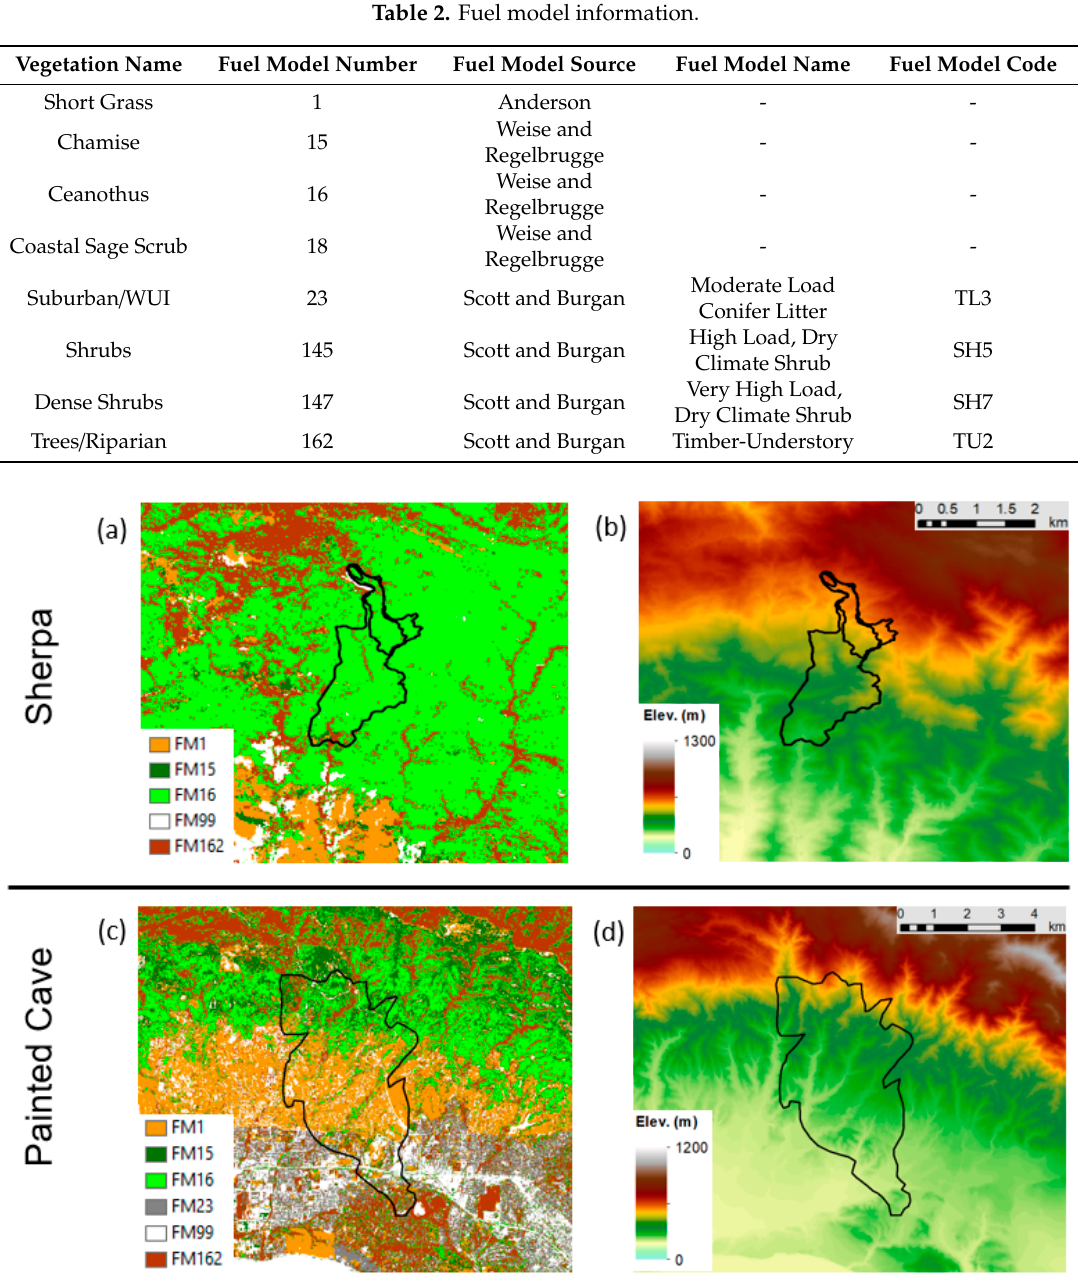
Figure 2. Fuel maps ( a , c ) and elevation ( b , d ) rasters for the Sherpa ( a , b ) and Painted Cave ( c , d ) fires. The black polygons are the fire perimeters at 1600, 1800, and 1900 PDT for the Sherpa Fire, and the final perimeter for the Painted Cave Fire. Fuel type numbers and names are indicated in Table 2.